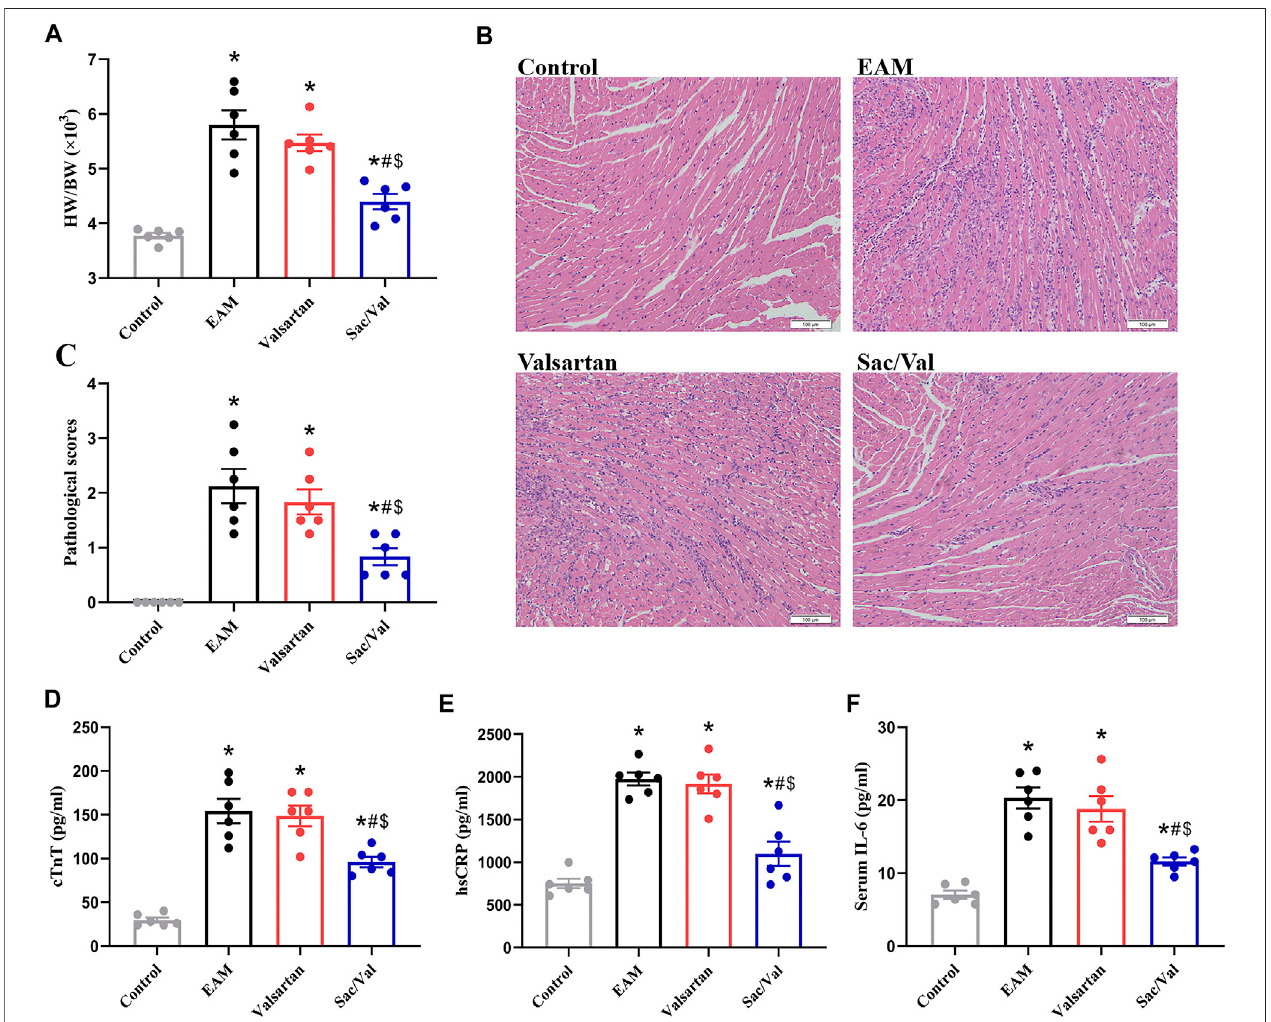
FIGURE 1 | Sac/Val attenuated the severity of EAM. (A) HW/BW in each treatment group. (B) Typical histopathologic pictures of myocardial tissues (H and E staining, × 200). (C) Thestatisticalgraphofpathologicalscoresineachtreatmentgroup. (D) LevelsofserumcTnTineachtreatmentgroup. (E) LevelsofserumhsCRPin eachtreatmentgroup. (F) LevelsofserumIL-6ineachtreatmentgroup.Allexperimentshadsixmicepergroupanddatawereexpressedasmeans ± SEMandanalysed by one-way ANOVA. * p < 0.05 vs. Control group; # p < 0.05 vs. EAM group; $ p < 0.05 vs. Valsartan group.